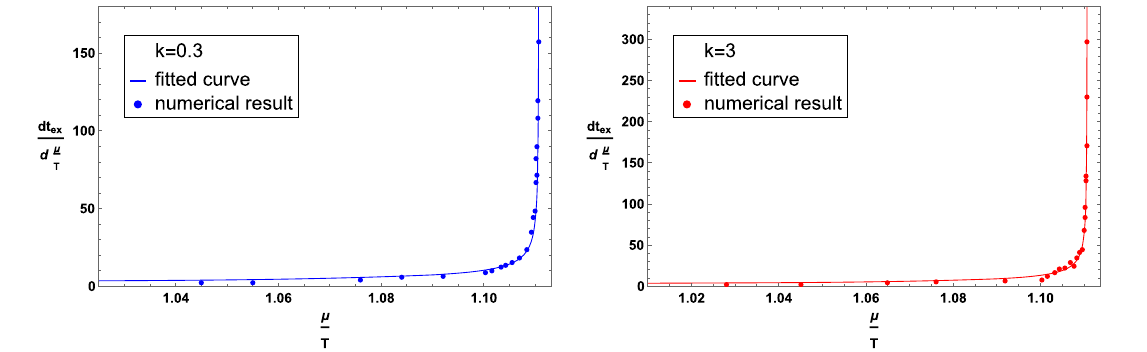
) (cid:2) =1.11072 T